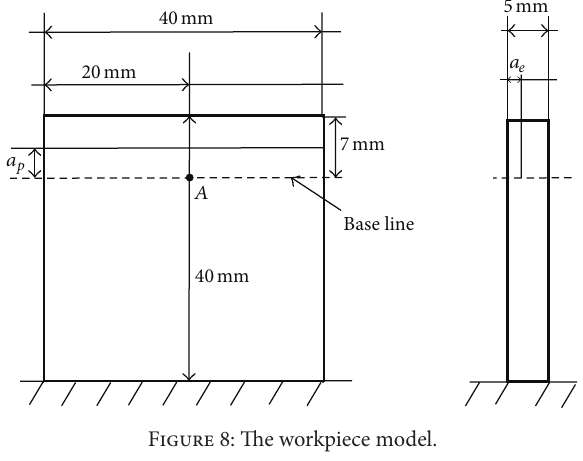
Figure 8: The workpiece model.